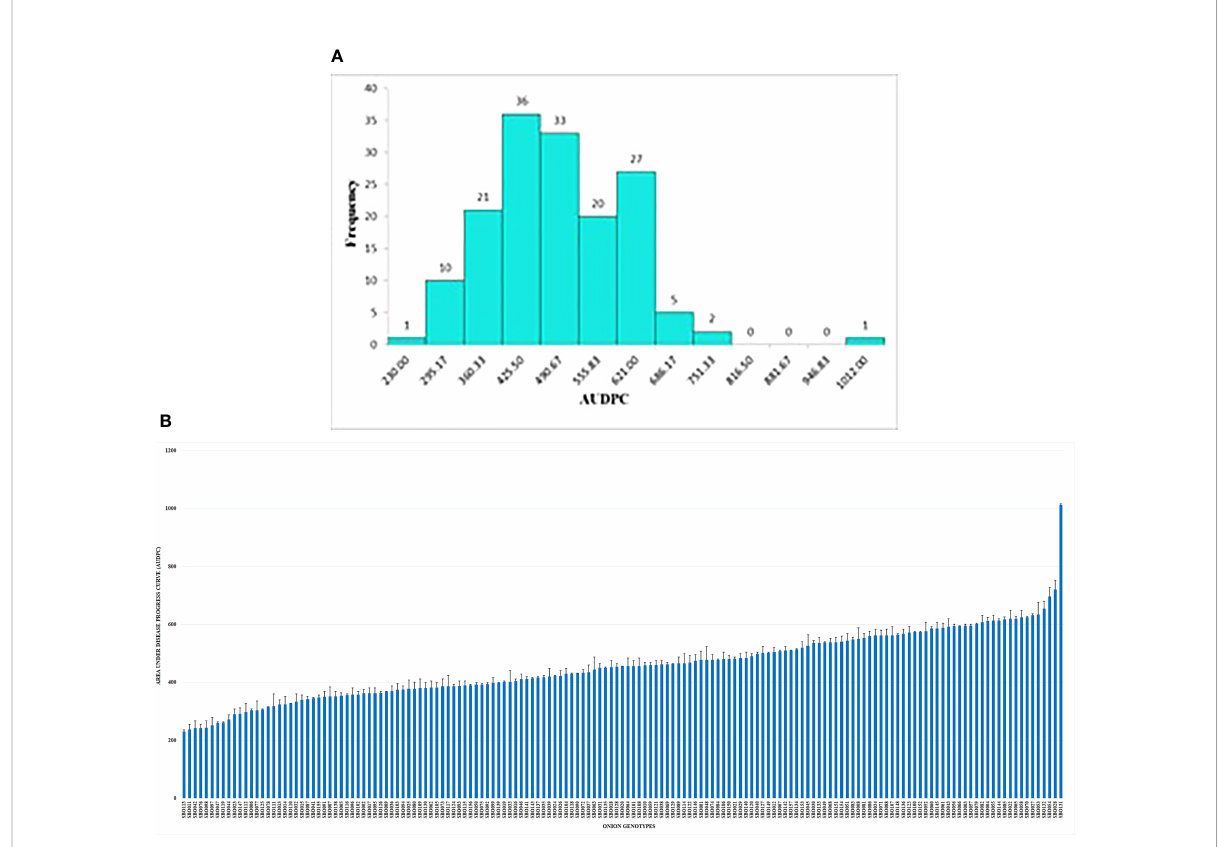
FIGURE 6 (A) Frequency distribution of onion genotypes based on the area under the disease progress curve (AUDPC). (B) Reaction of onion genotypes based on the area under the disease progress curve